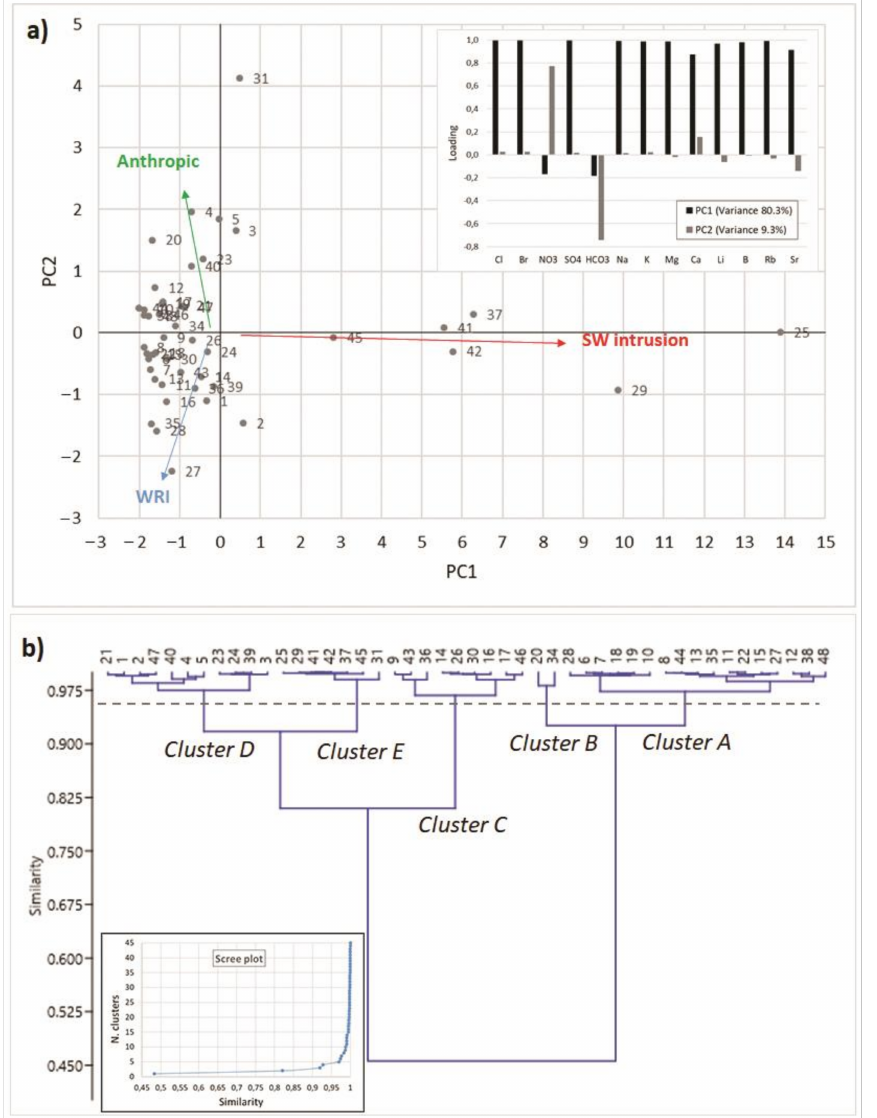
Figure 3. ( a ) Principal component analysis, ( b ) cluster analysis. WRI = water-rock interaction, SW Intrusion = seawater